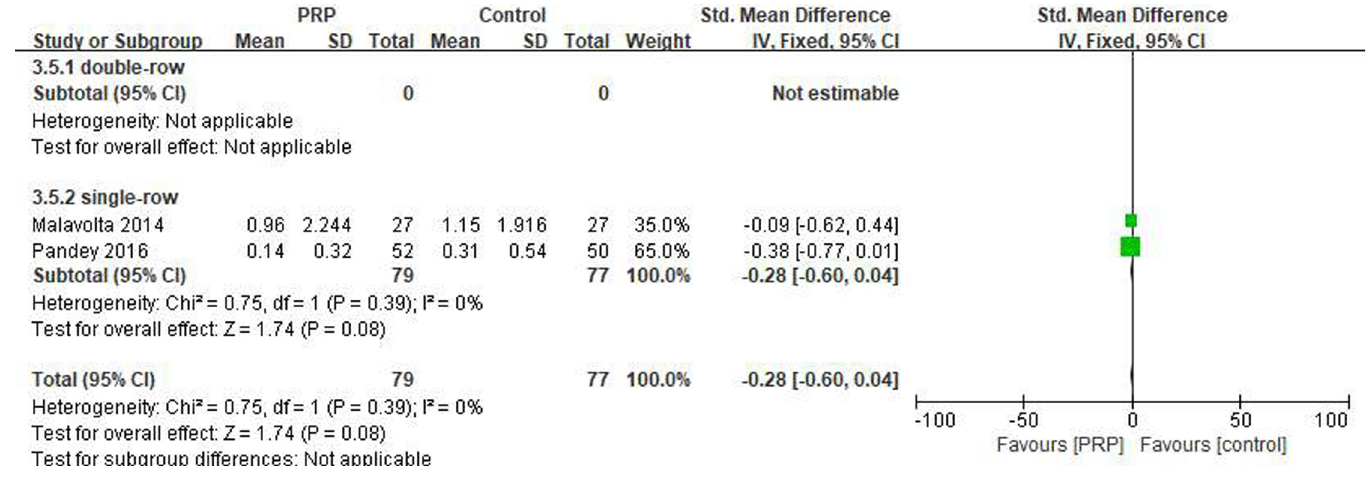
Fig 12. Forest plot for the long-term VAS.